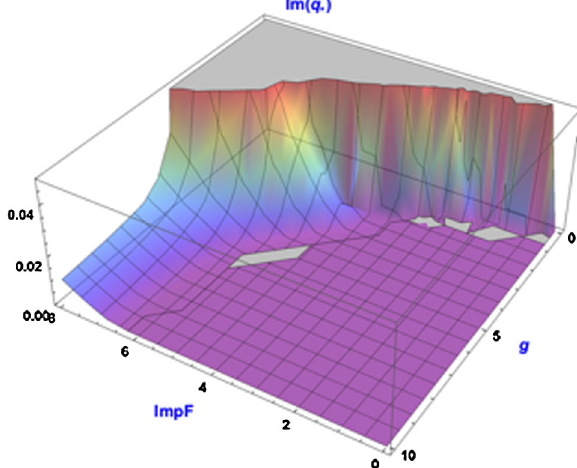
FIG. 26. Growth rate for 25 ns LHC beam with the resistive feedback and ImpF ¼ 1 . 5 . Coupled bunch interaction is in- cluded. Note the lake of stability; for the multibunch regime, the lake is limited by ImpF ¼ 1 . 7 .